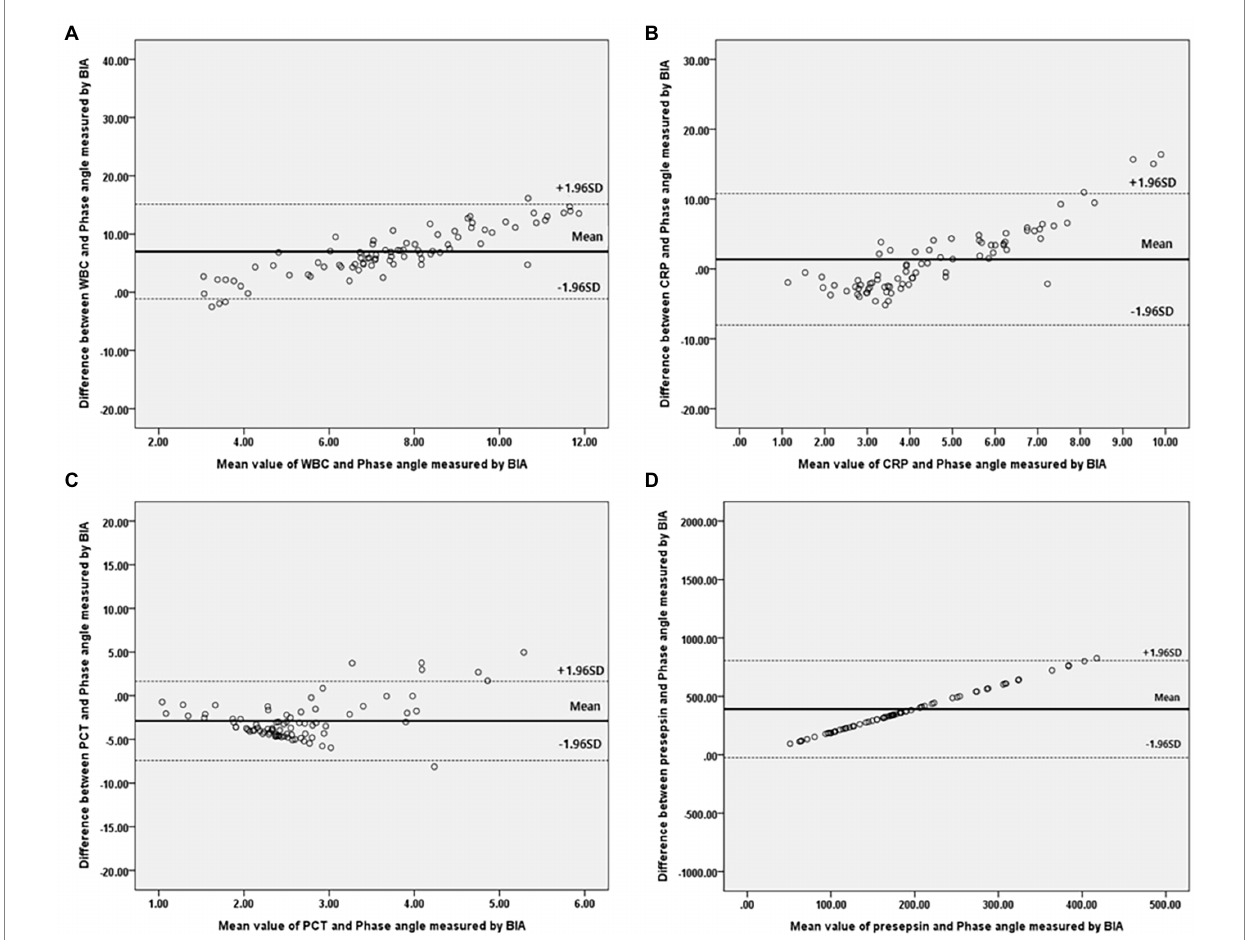
FIGURE 4 Bland–Altman plot for analyzing the agreement between the inflammatory marker and Phase angle on BIA in females. (A) White blood cell, (B) C-reactive protein, (C) Procalcitonin, (D) Presepsi. *BIA: bioelectrical impedance